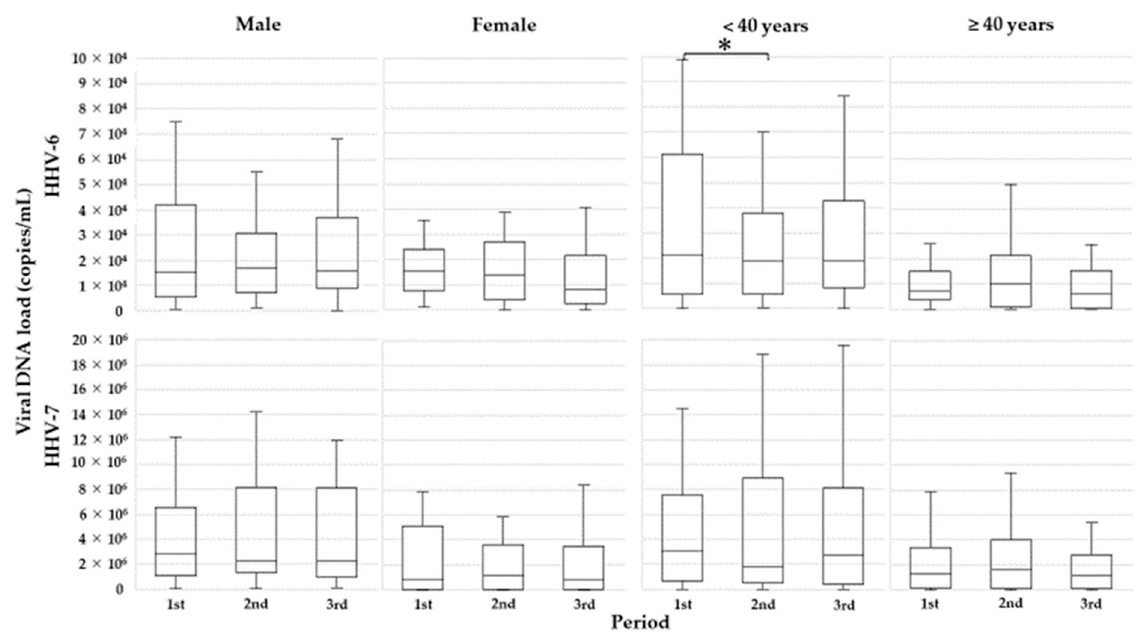
Figure 4. Comparison of mean HHV-6 and HHV-7 DNA loads over the three periods, by subgroup. *: Significantly different between the first and second periods.